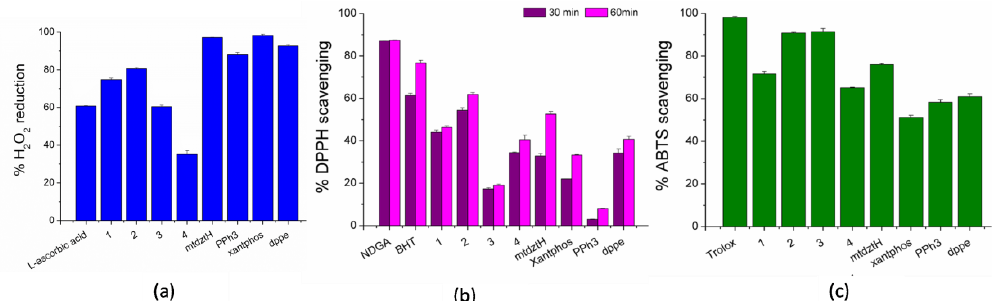
Figure 5. In vitro antioxidant ability of compounds 1 – 4 , as well as their ligands mtdztH, dppe, xantphos, and PPh 3 in free form: (a) H 2 O 2 reducing ability (% H 2 O 2 ), (b) DPPH scavenging activity (% DPPH) and (c) ABTS scavenging activity (% ABTS).